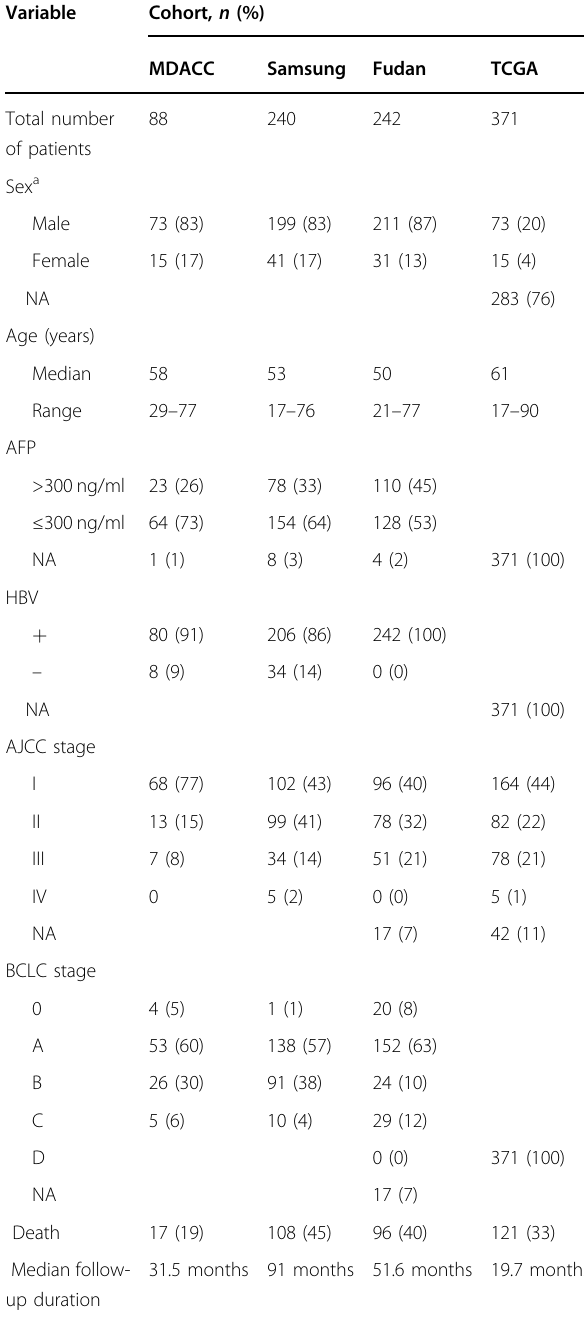
Table 1 Baseline clinical and pathologic features of patients with hepatocellular carcinoma in all four